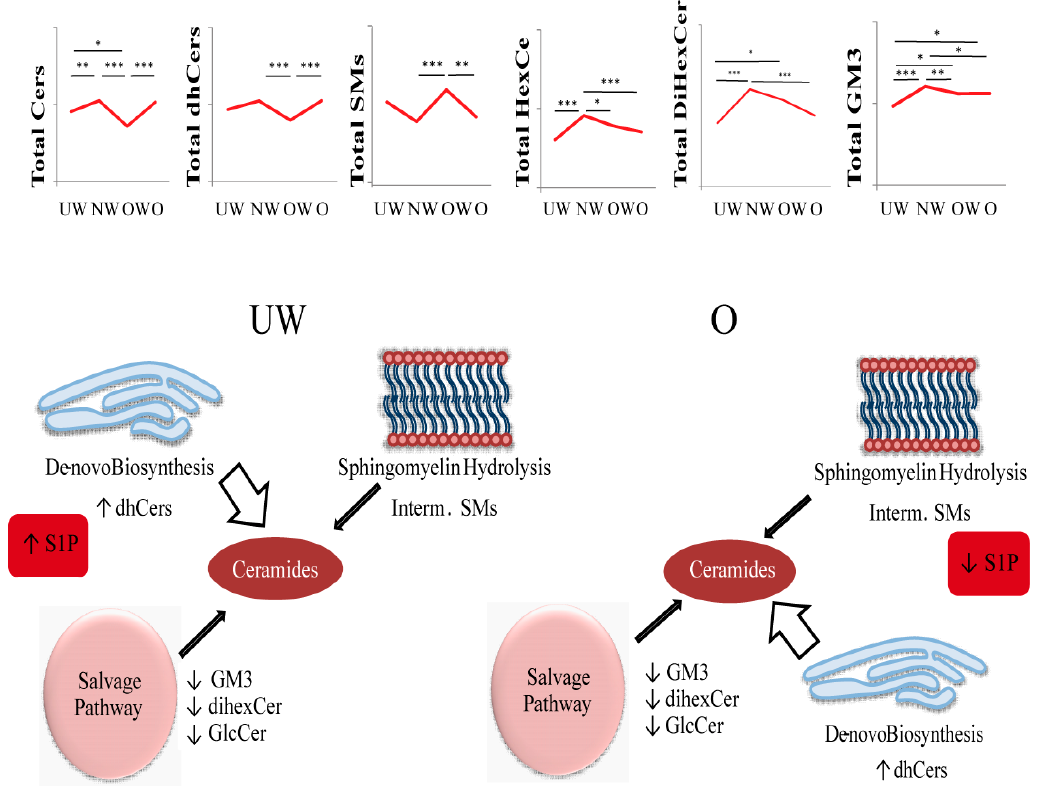
Figure 5. Summary of the altered ceramide-biosynthesis pathways. Different size arrows indicate the different involvement of Cers biosynthetic pathways in UW and O. LC-MS and LC-MS/MS results for total Cers, total dhCers, total SMs, total HexCer, total dihexCer, and total GM3. Data are expressed as pmol/mL in Log scale; p values are expressed as * p -value < 0.05, ** p -value < 0.01, and *** p -value < 0.001.